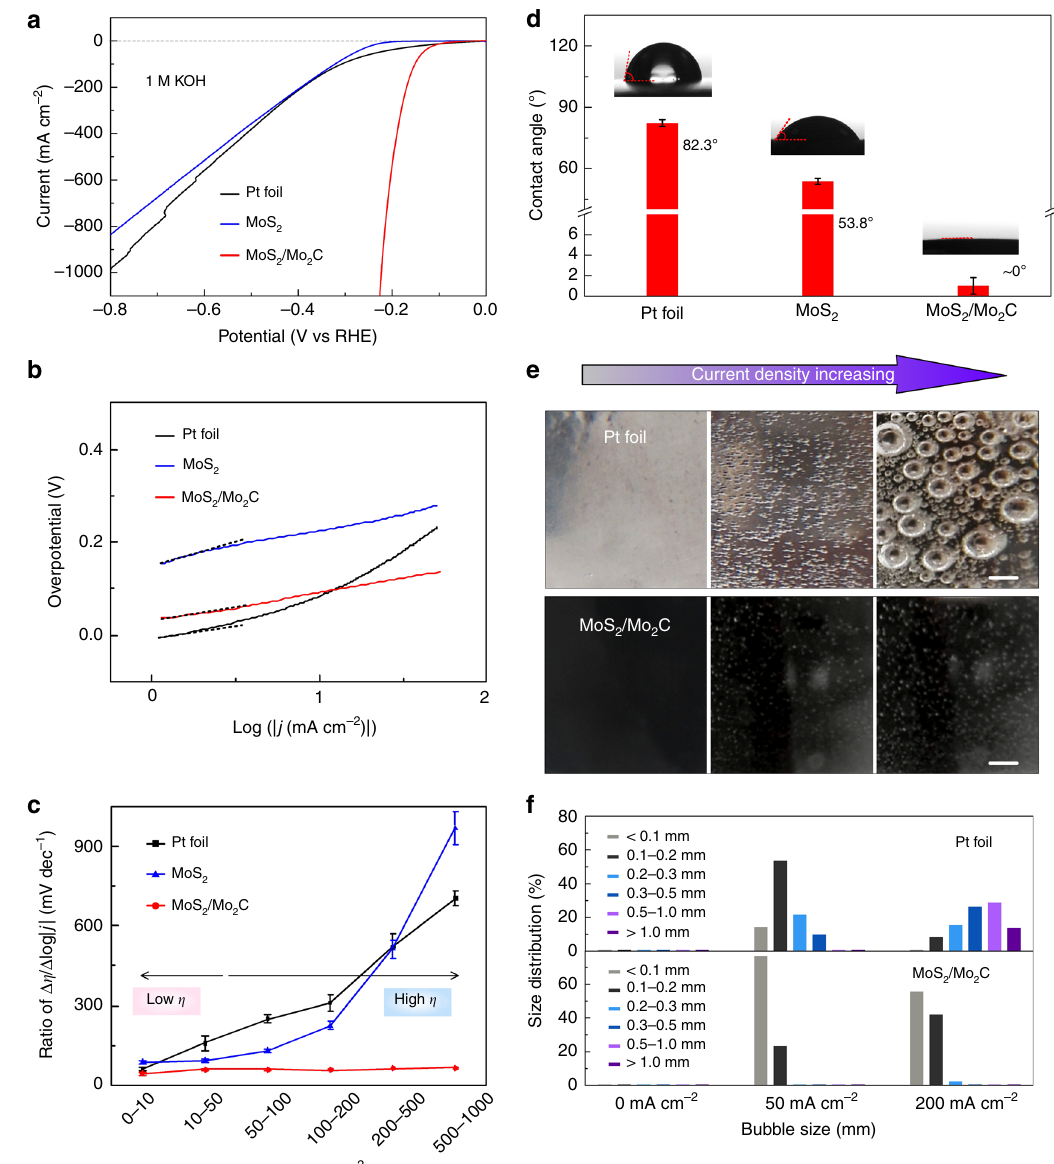
Fig. 2 Electrocatalytic performance of different catalysts at high current densities. a Polarization curves and b Tafel curves after iR compensation for a Pt foil, MoS 2 , and MoS 2 /Mo 2 C in KOH (1 M) at a scan rate of 5 mV s − 1 . c Ratios of Δ η / Δ log| j |, i.e., R η / j , for the three catalysts in different current density ranges, which can be used as an indicator to evaluate the performance of a catalyst at high current densities. All points were tested three times, and error bars correspond to standard deviations. Source data are provided as a Source Data fi le. d CAs of a KOH (1 M) droplet on the surfaces of the catalyst. The CAs were measured for at least three times for each sample, and error bars correspond to standard deviations. Source data are provided as a Source Data fi le. e Photos show sharp contrast during the release of H 2 bubbles on the Pt foil and on MoS 2 /Mo 2 C surfaces. The scale bars are 1 mm. f Size distributions of H 2 bubbles on the surfaces of a Pt foil and MoS 2 /Mo 2 C. Source data are provided as a Source Data fi